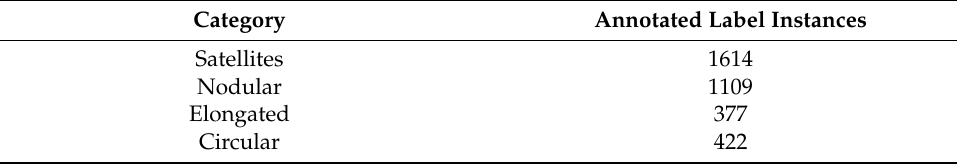
Table 3. The number of each particle category found within the